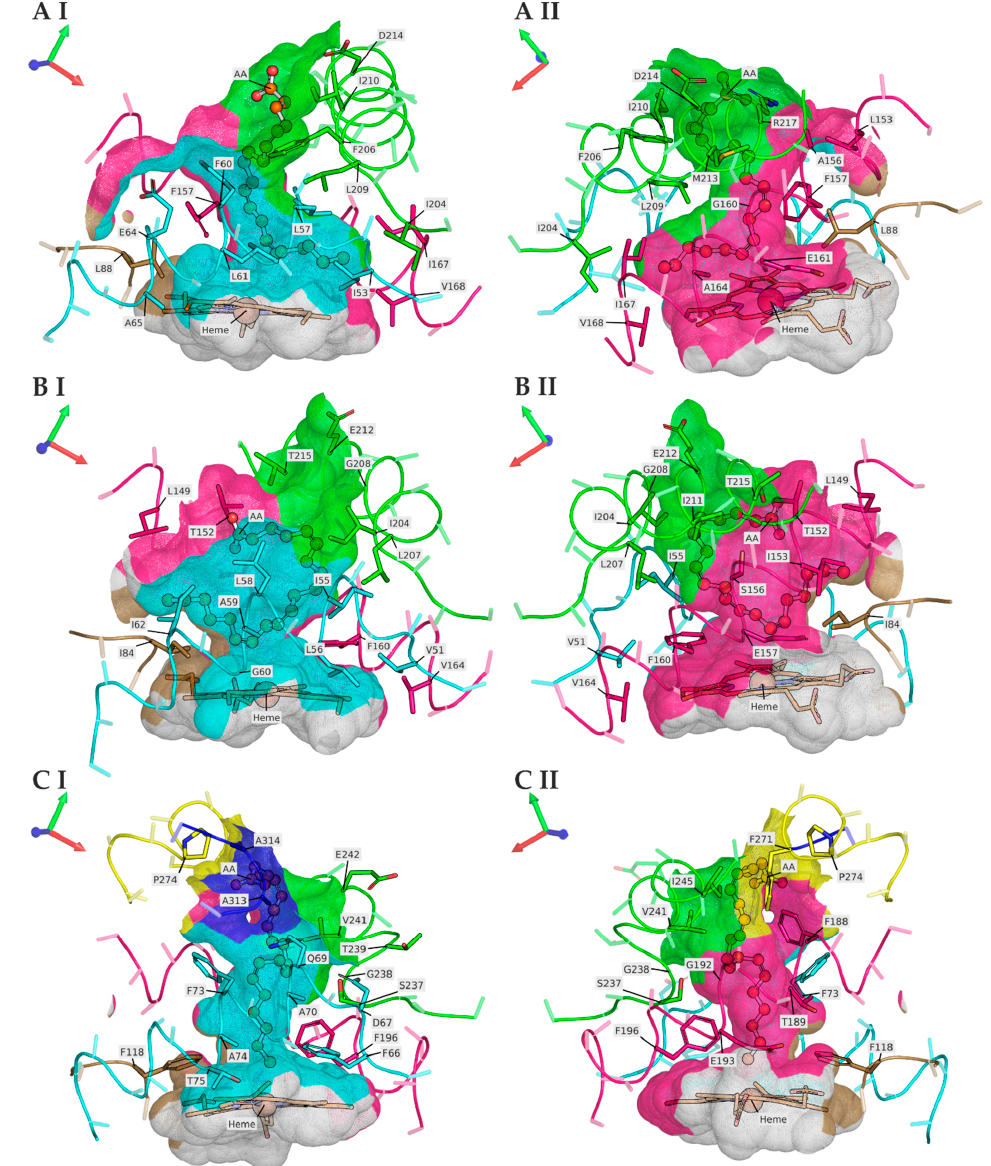
Figure 4. Carved solvent excluded surface (SES) of the heme-pocket and substrate access channel (SAC) of Tan UPO (( AI ) + ( AII )) (AlphaFold2 simulation), Mro UPO (( BI ) + ( BII )) (PDB#: 5FUJ Chain A) and Aae UPO (( CI ) + ( CII )) (PDB#: 2YOR chain A); orthoscopic view. Hydrogens are visually hidden. Protein backbone segments that outline the SAC are depicted as colored ribbons and the respective SES segments are colored identically (cyan, hot pink, sand, green, yellow, blue). The prosthetic heme and protein side-chains are depicted as sticks, the ligand arachidonic acid (AA) as ball-and-sticks and the heme-iron as a sphere. Protein side-chain residues are generally transparent and shown only for C α to C β (with the exception of glycine) to reduce visual clutter. Side-chain residues of interest, on the other hand, are shown in full length and opaque. Black outlines were added to improve the visibility of obscured molecules and residues of interest. Labels are in the IUPAC one-amino-acid code. Stick-carbons are colored in either the color of the respective main-chain segment or in orange (heme and AA), oxygen atoms in red, nitrogen atoms in blue. All UPOs were structurally aligned using the CEAlign method (PyMol v. 2.2.5), and the coordinate axes in the upper left corner indicate the position (point-of-view) in the common 3D